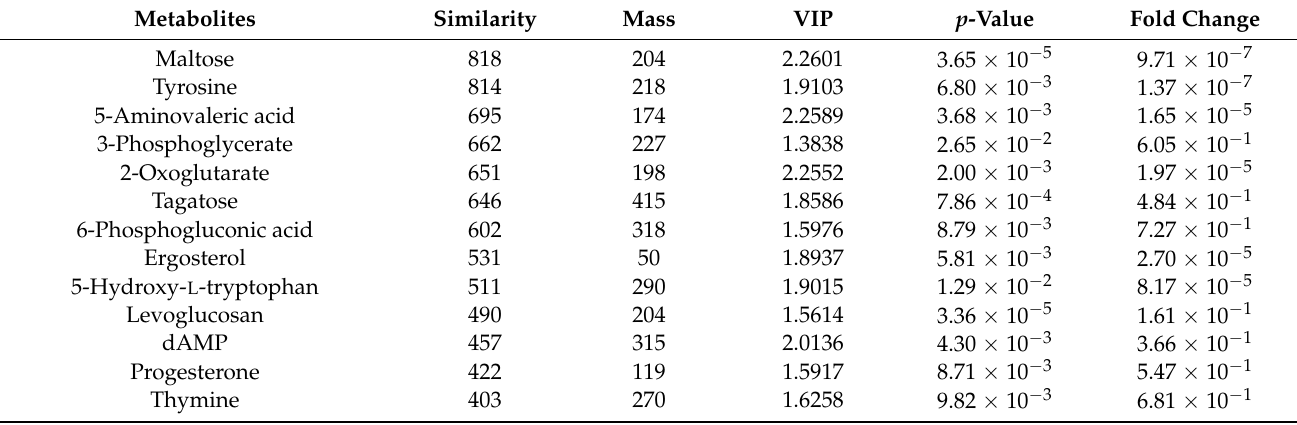
Table 2. Significantly differentially abundant metabolites that were decreased in termites fed a M. micrantha leaves diet relative to those fed a pinewood